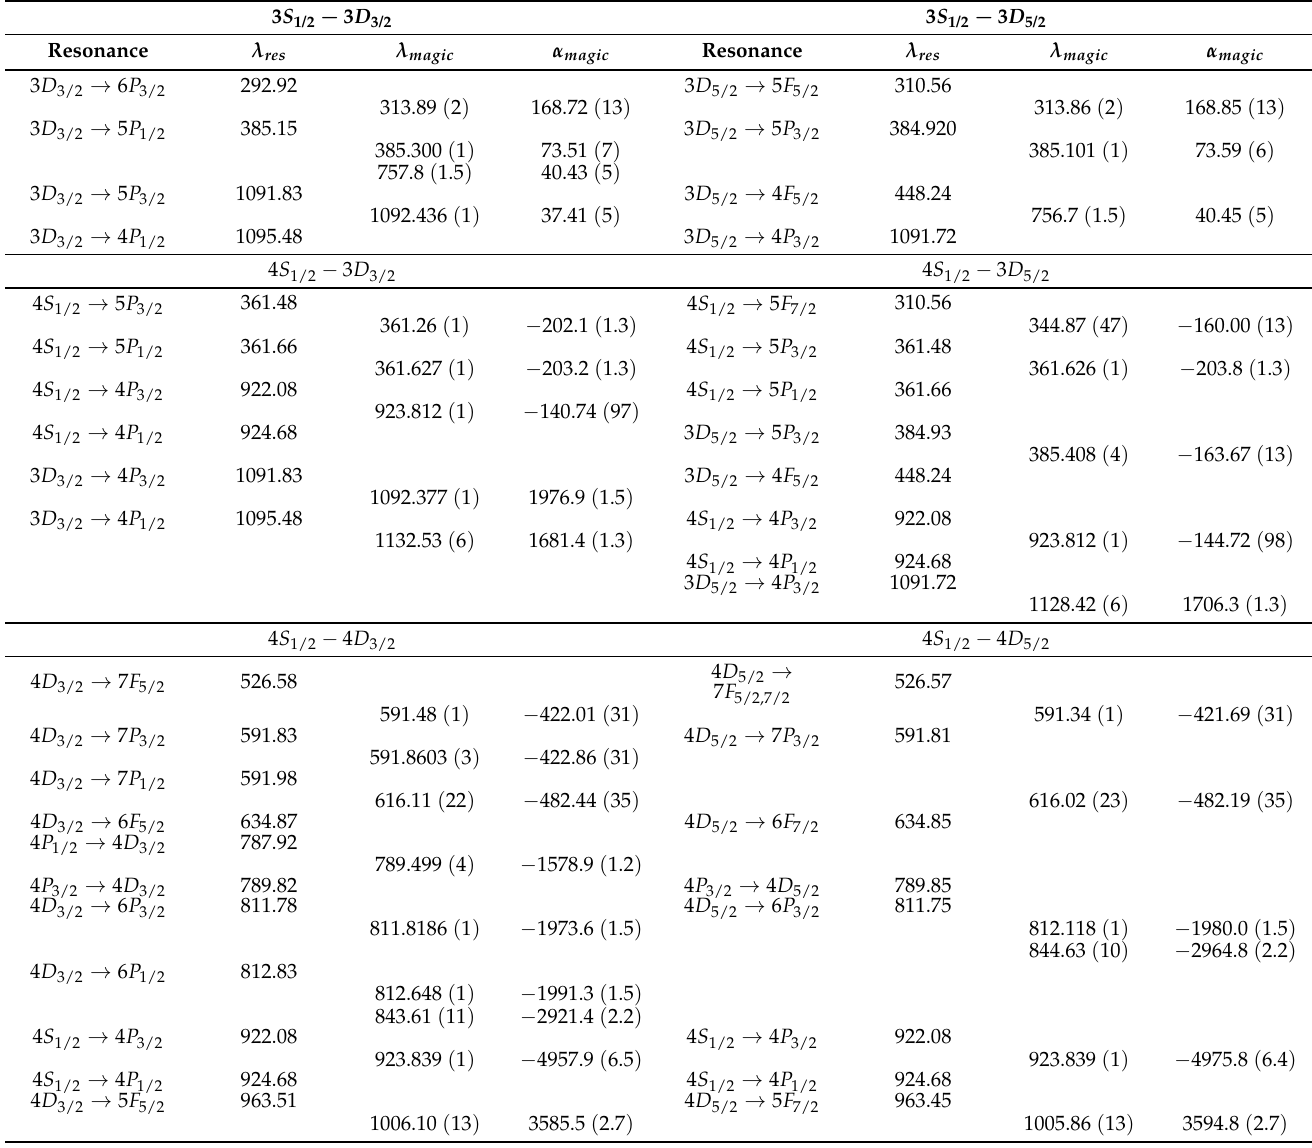
Table 1. Magic wavelengths λ magic (in nm) with their corresponding polarizability α n ( ω ) (in a.u.) for ( 3,4 ) S 1/2 − 3 D 3/2,5/2 and 4 S 1/2 − 4 D 3/2 transitions in Mg +